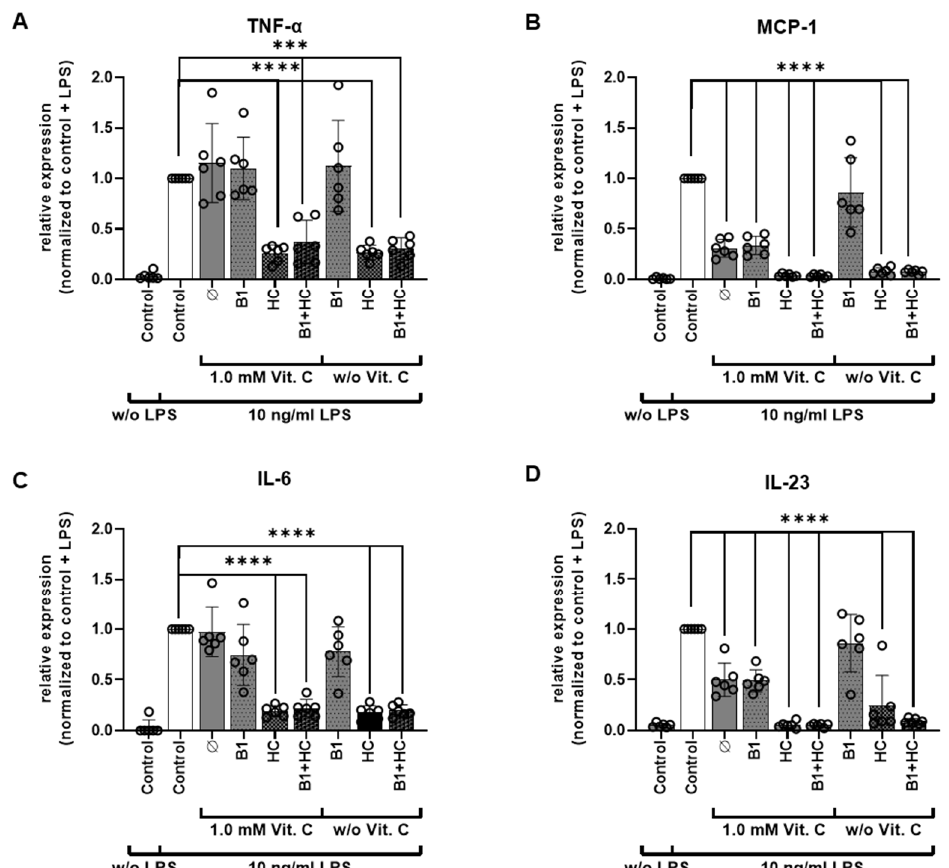
Figure 5. Real-time PCR analysis of TNF- α , MCP-1, IL-6, and IL-23 after vitamin C, vitamin B1, and hydrocortisone treatment. ( A – D ). PBMCs were treated for 6 h with either vitamin C (1 mM), vitamin B1 (1 µM), or hydrocortisone (2 µM) alone or in combination and with (10 ng/mL) or without LPS. QRT-PCR results show levels of TNF- α ( A ), MCP-1 ( B ), IL-6 ( C ), and IL-23 ( D ) mRNA expression in comparison with untreated cells and normalized to the LPS stimulated control. TBP and β -actin mRNA expression were used as housekeeping genes. ***: p ≤ 0.001; ****: p ≤ 0.0001. Additional data analysis stratified according to gender is available as Figure S6. B1 = vitamin B1; HC = hydrocortisone; IFN = interferon; IL = interleukin; LPS = bacterial lipopolysaccharides; MCP = monocyte chemo-attractant protein; PBMCs = peripheral blood mononuclear cells; qRT-PCR = quantitative reverse transcription-polymerase chain reaction; TBP = TATA box binding protein; TNF = tumor necrosis factor; Vit. C = vitamin